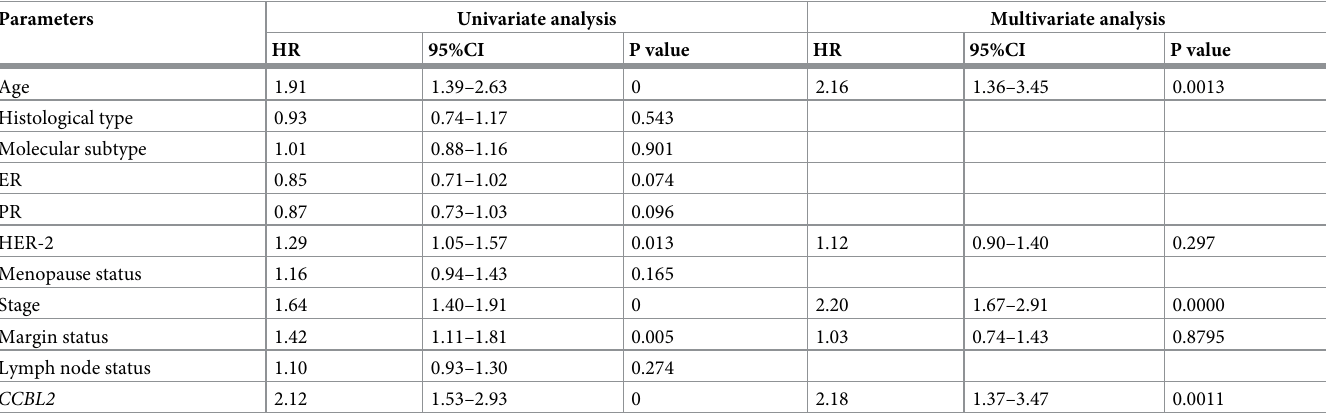
Table 3. Univariate and multivariate analyses of overall survival in breast cancer